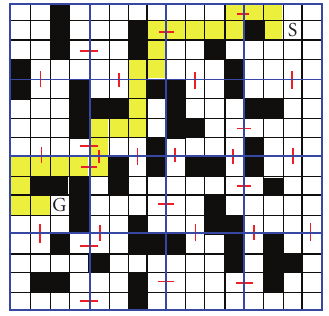
Figure 14: Multi-level abstract graphs with 16 “1-clusters” and 4